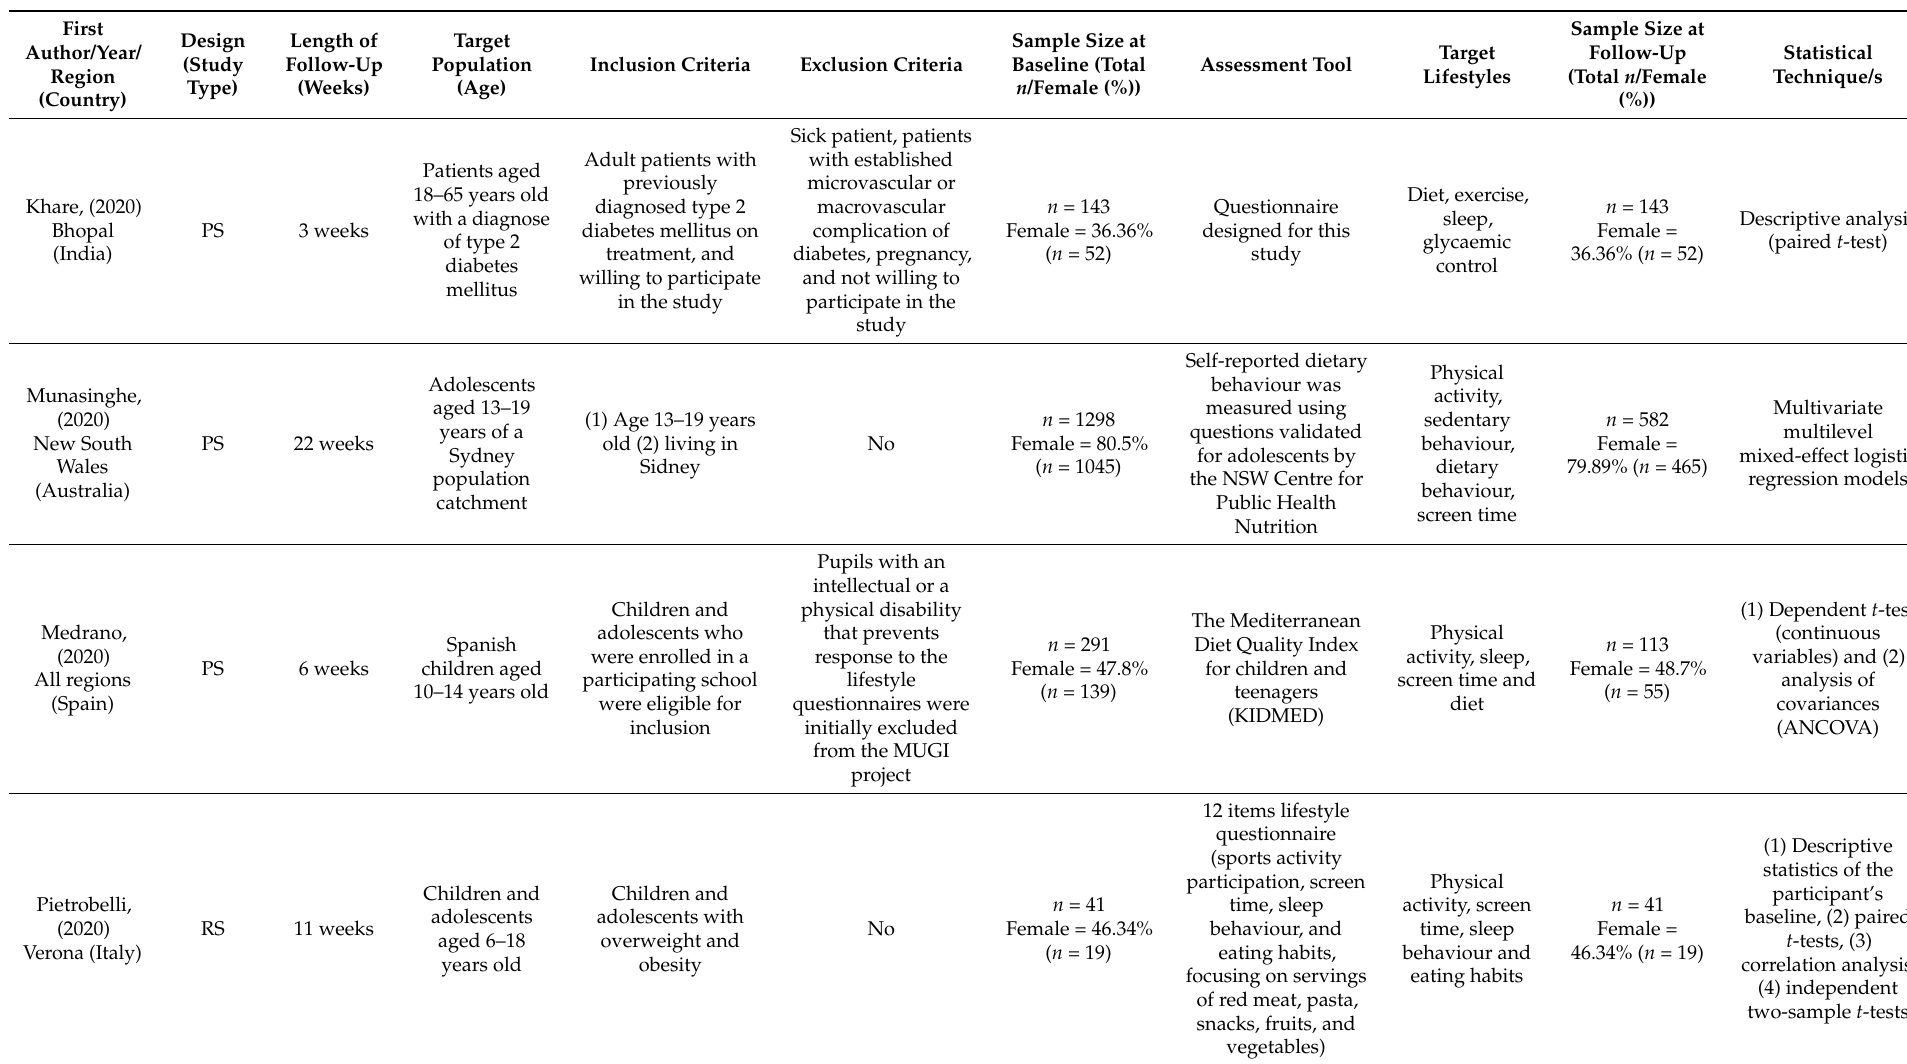
Table 3. Characteristics of the included